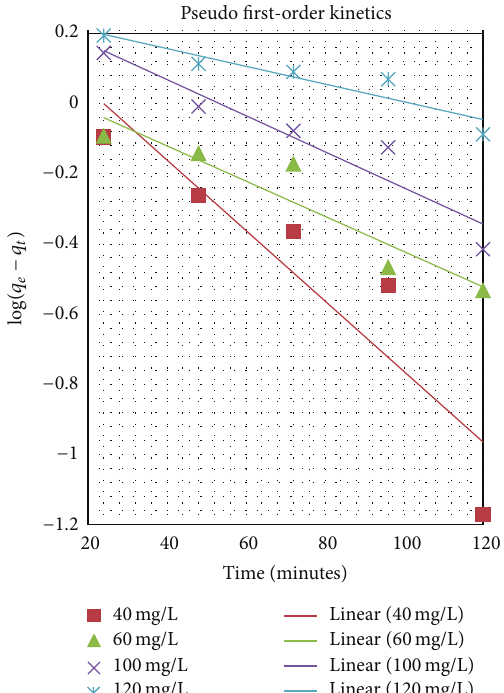
Figure 4: Pseudo-first-order kinetics, pH 2.5, ambient temperature, and 4g/L absorbent dose.